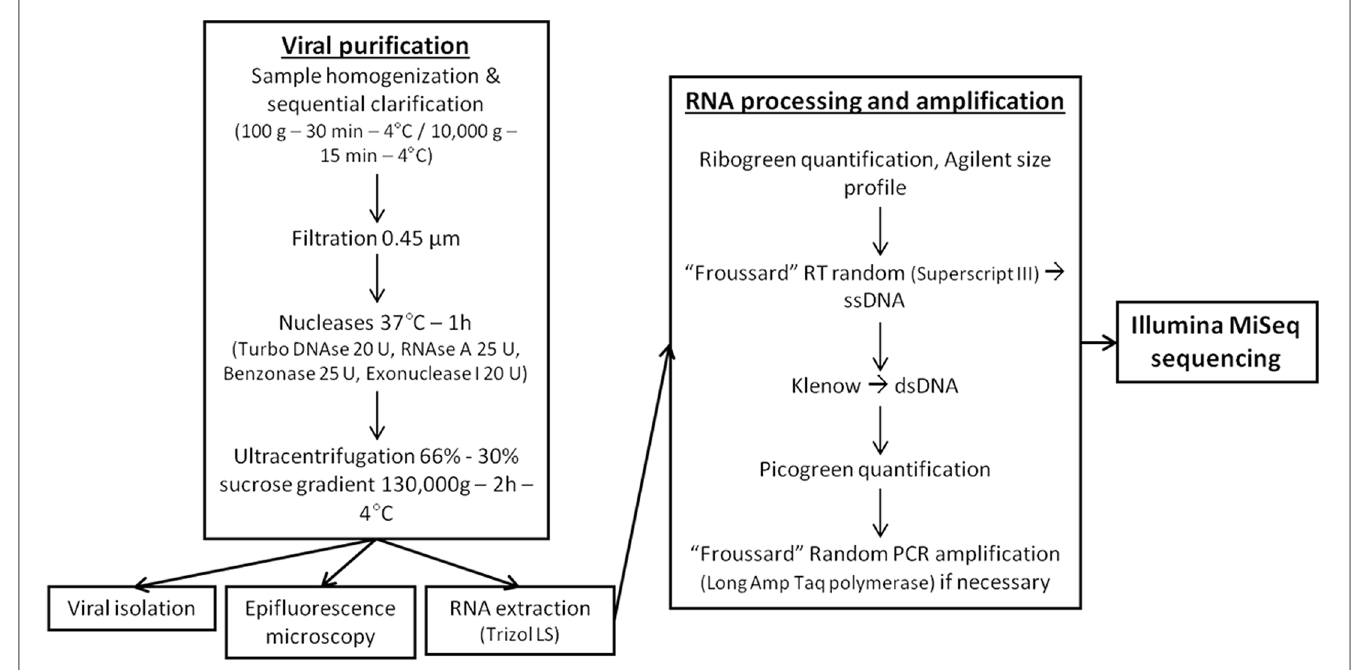
Fig 1. General overview of the protocol.